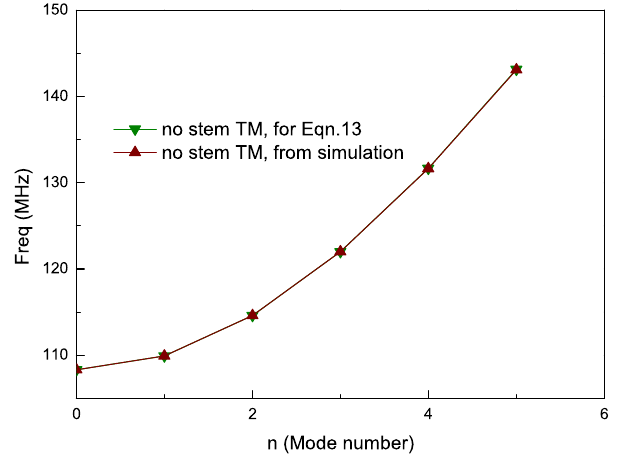
FIG. 5. Dispersion curves of TM 01 cavity without stems from analytic calculation (green) and from simulations (brown).